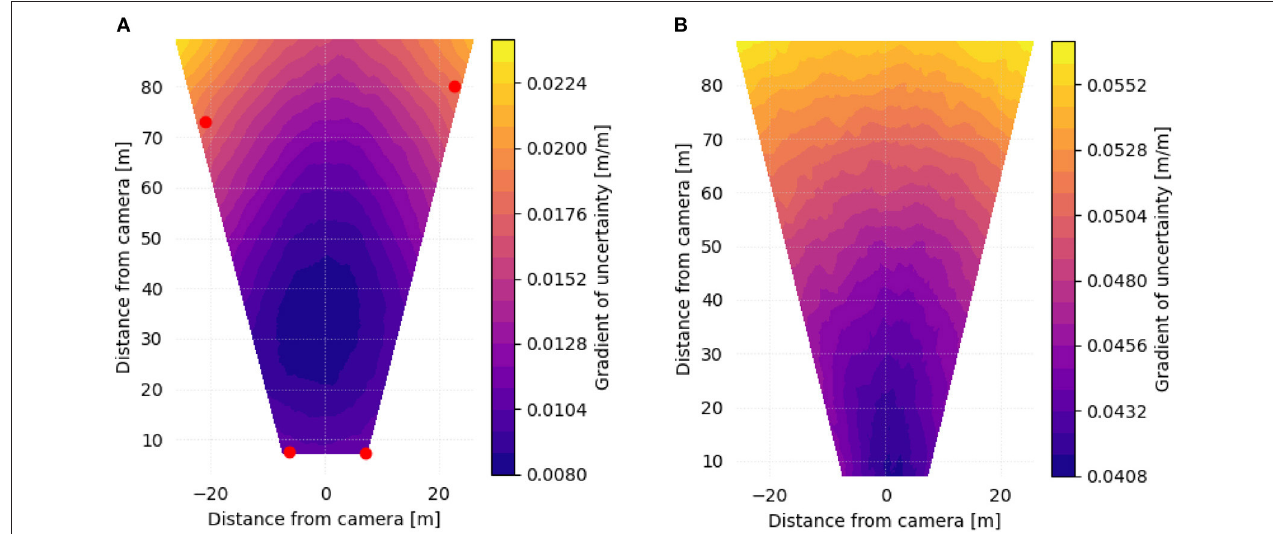
FIGURE 6 | Contours of the 95th percentile of the gradient of spatial uncertainty estimated at each pixel footprint in an oblique view camera setup, after correcting the images for radial distortion. (A) Using 4 GCPs located near the corners of the FOV (red dots). (B) Using direct georeferencing.